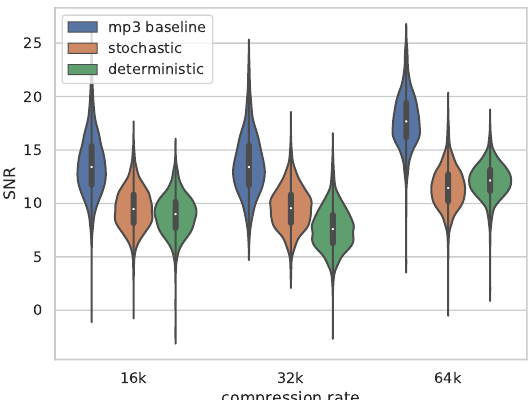
Figure 4. Violin plots of objective metrics for stochastic ( sto ) and deterministic ( det ) models and MP3 baselines ( mp3 ) for different compression rates (16 kbit/s, 32 kbit/s, 64 kbit/s). Higher values are better for ODG, DI and SNR; lower values are better for LSD and